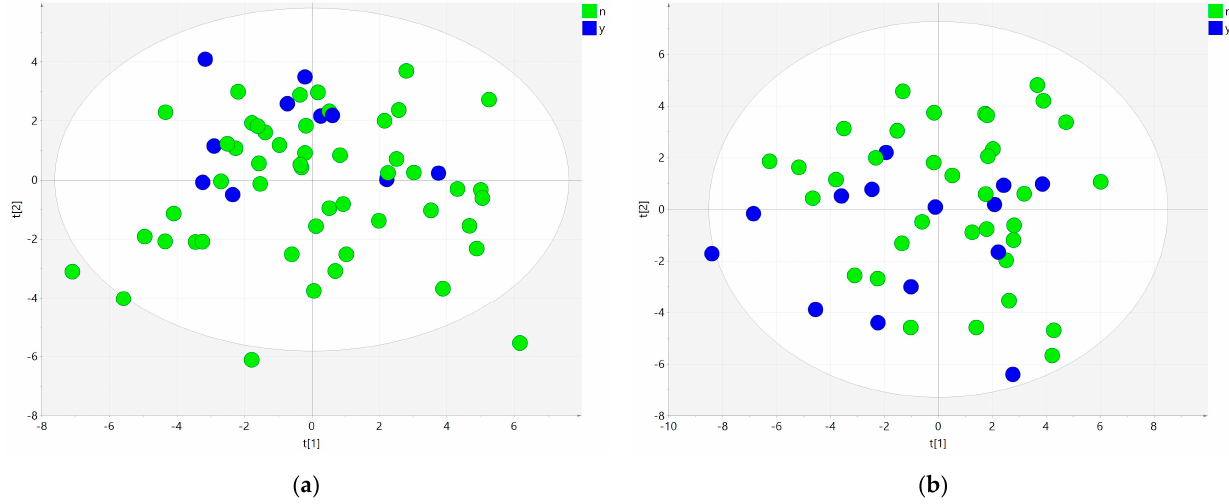
Figure 4. Explorative analysis on polar lipid subset. PCA score plots of samples from ( a ) group A and ( b ) group D. Samples are colored according to prior statin use (blue) or no prior statin use